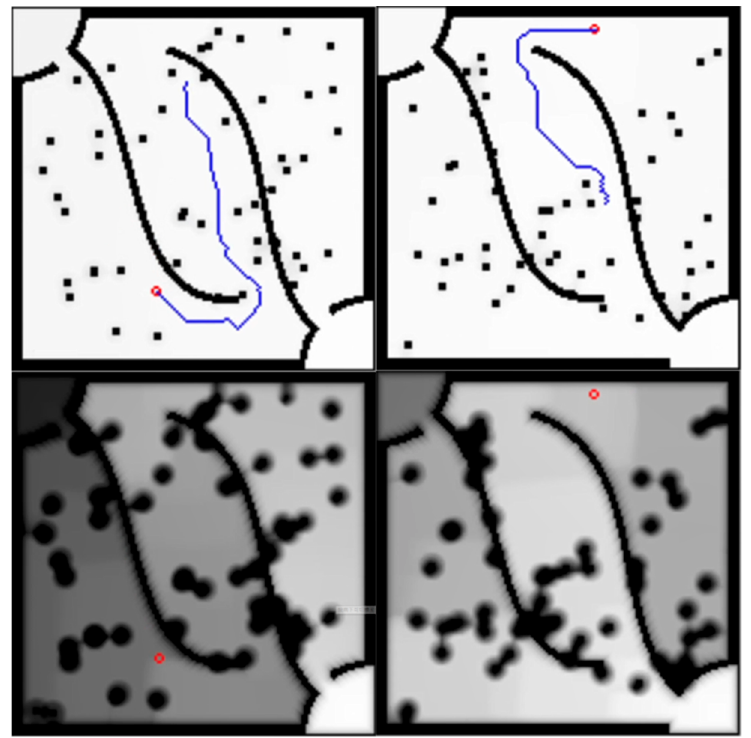
Figure 6. Real-time path planning with 50 obstacles on a changing map.